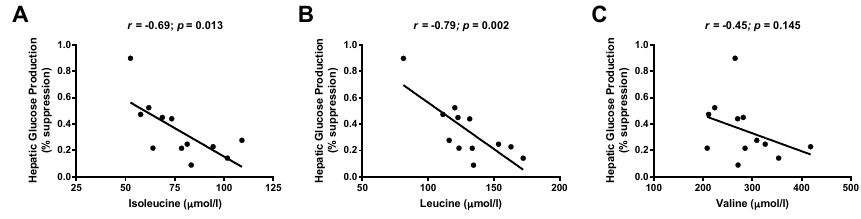
Figure 3. Association between hepatic glucose suppression during a two-step hyperinsulinemic-euglycemic clamp and: ( A ) isoleucine; ( B ) leucine; and ( C ) valine concentrations. Rank correlations between variables are indicated by Spearman’s rank correlation coefficient ( r ).